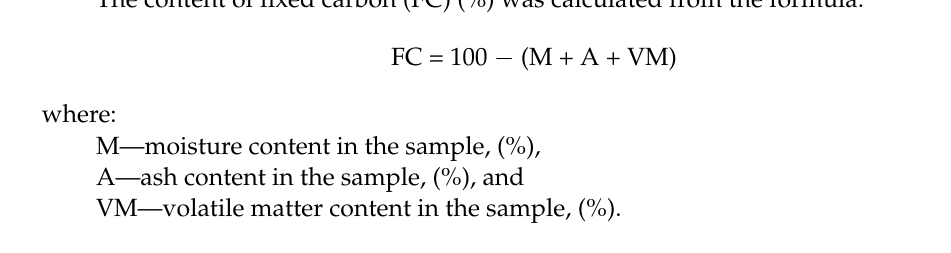
Figure 4. A stand for calorimetric measurements [40].